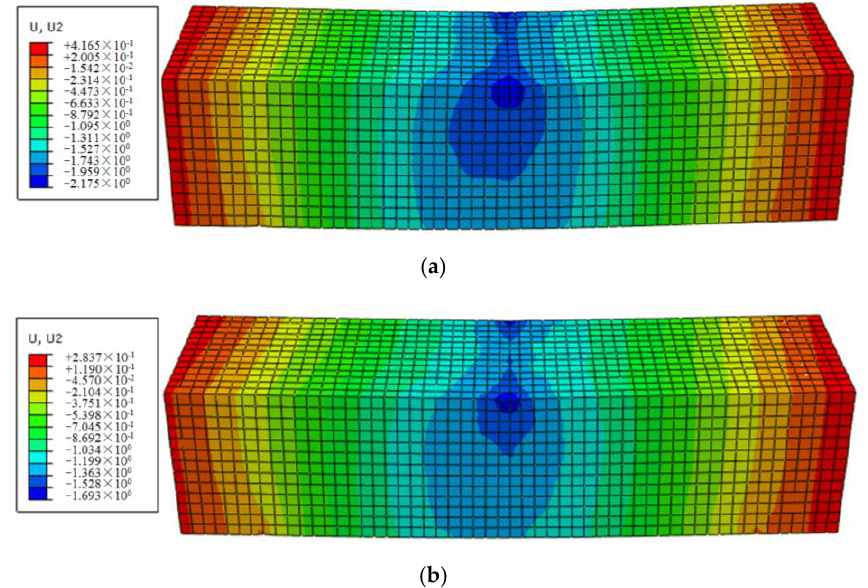
Figure 12. Displacement contour of the 3D model under different BF contents at 3600 s as: (a) 0.1% fiber content; (b) 0.2% fiber content.